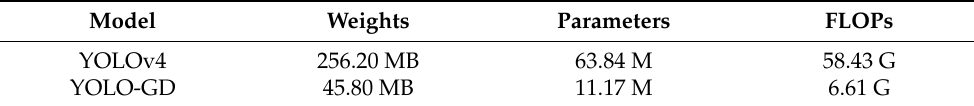
Table 5. Comparison of parameters between YOLOv4 and